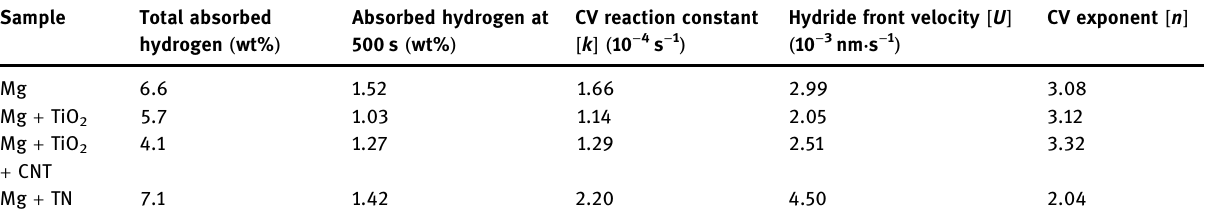
Table 1: Maximum absorbed hydrogen, initial sorption rate, and the fi tted parameters of the CV model